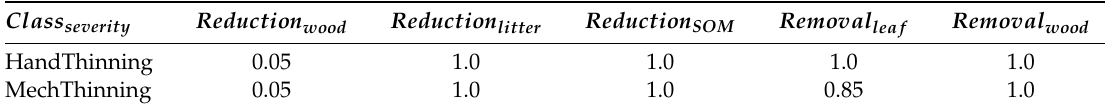
Table A29. Harvest reduction parameters; inactive.